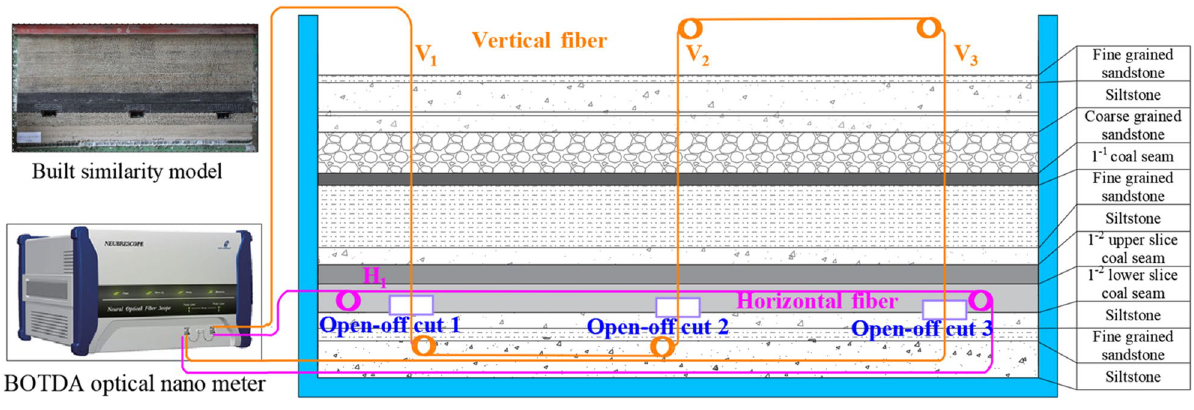
Figure 7. Schematic diagram of open-off cut